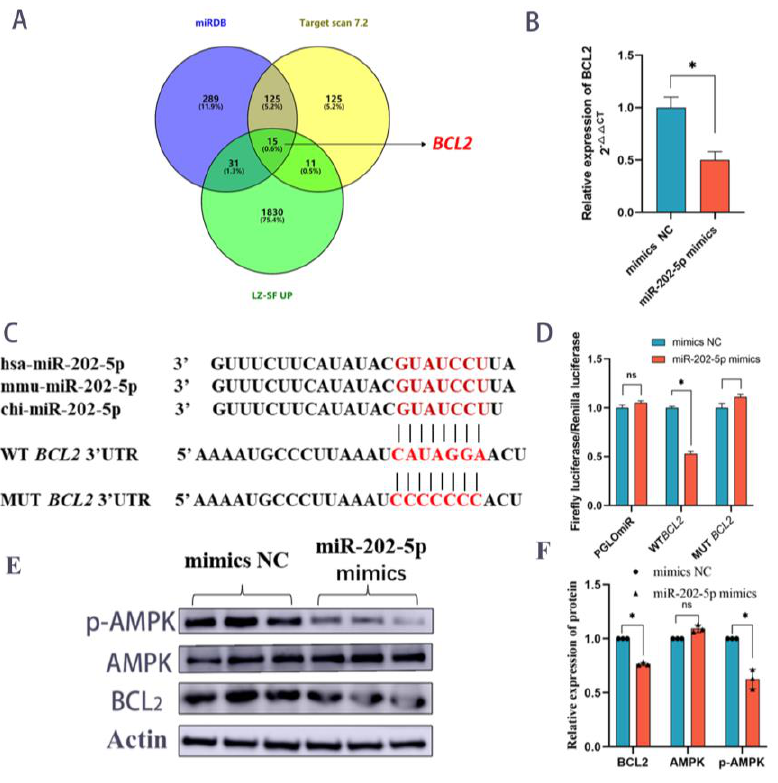
Figure 7. miR-202-5p targets the BCL2 gene. ( A ) miRDB with Target scan 7.2 databases to predict target genes. ( B ) qPCR results of BCL2 gene after overexpression of miR-202-5p. ( C ) Sequence comparison of miR-202-5p with dual luciferase results. ( D ) Fluorescence changes of miR-202-5p and mimics NC after co-staining with PGLOmir, WT-BCL2 and MUT-BCL2. Data are shown as mean ± SD values ( n = 6). * p < 0.05 was considered statistically significant. Ns: data results were not significant. ( E , F ) Western blotting results of p-AMPK, AMPK and BCL2 after overexpression of miR-202-5p.Data are shown as mean ± SD values ( n = 3). * p < 0.05 was considered statistically significant. ns: not significant for statistical results.